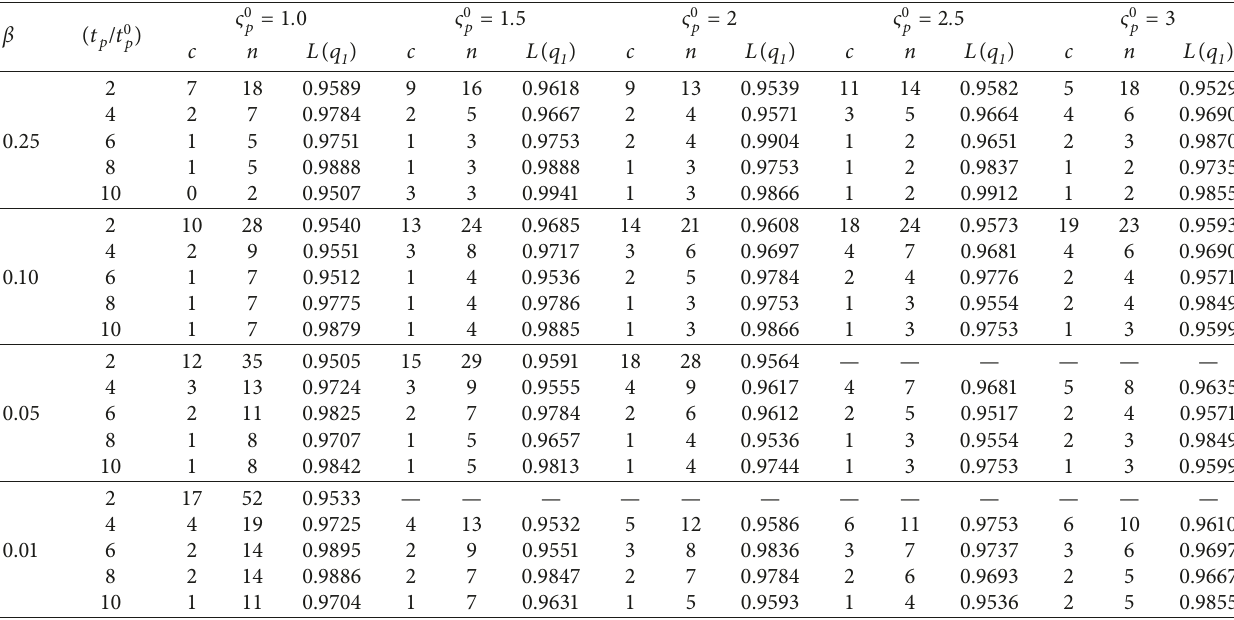
Table 4: The plan parameters and OC values for NGExp-Weibull distribution for φ � 0 . 5 , δ � 1 . 5, and k � 1 .